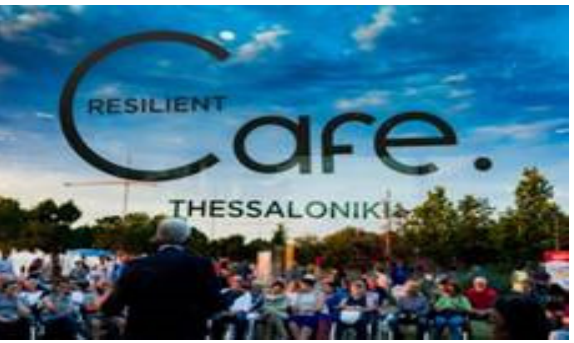
Figure 3. June 20, 2017—Resilient Day event. Source: Resilient Thessaloniki office archive. Figure 3. 20 June 2017—Resilient Day event. Source: Resilient Thessaloniki office